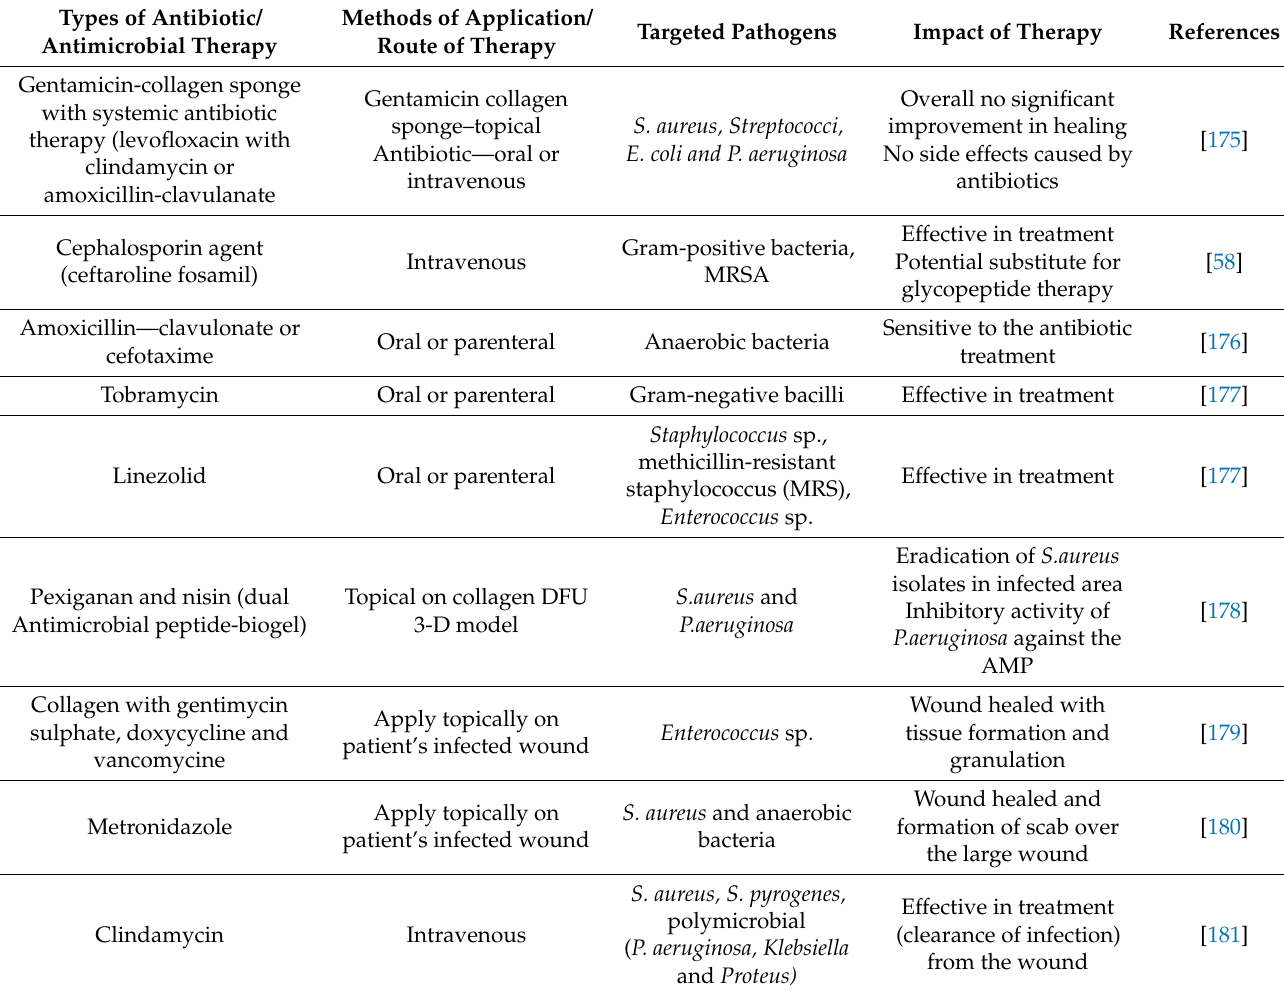
Table 2. Types of antibiotic/antimicrobial therapy, route of therapy, targeted pathogens, and impact to wound. Types of Antibiotic/ Antimicrobial